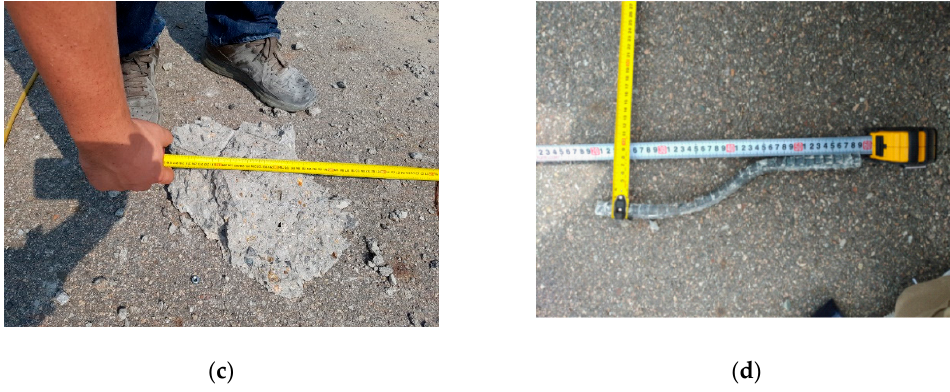
Figure 16. Photographs of CMB-17S after impacts. ( a ) Front face; ( b ) Rear face; ( c ) Concrete fragmentation 2.1 m away from CMB-17S; ( d ) Deformed dowel bar of the device allowing for deformation.